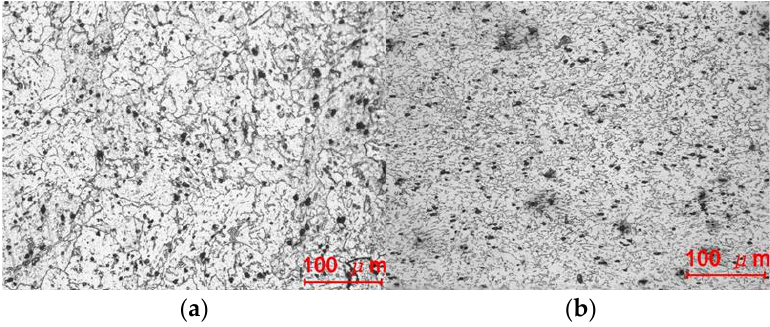
Figure 14. Microstructure of materials: ( a ) fractured and ( b ) non-fractured.